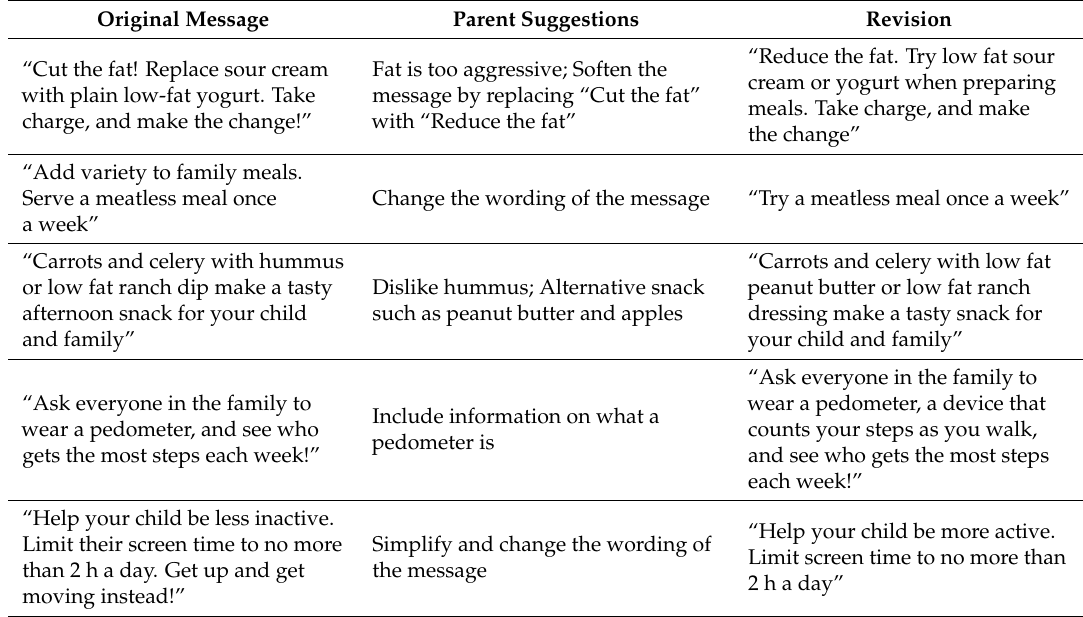
Table 7. Sample messages after parent